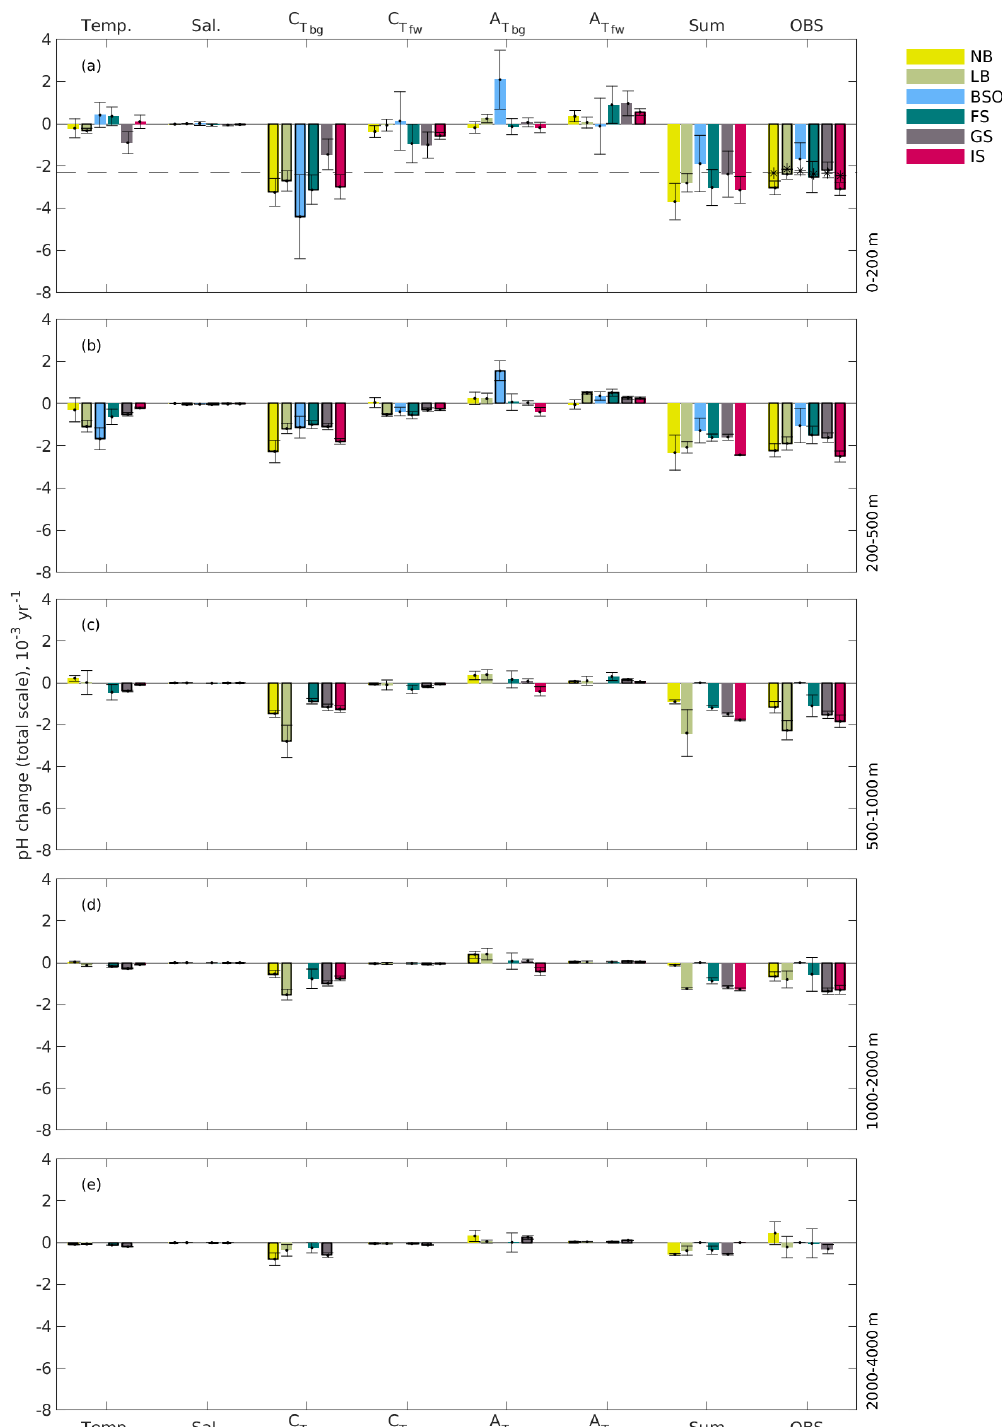
Figure 13. Contribution of observed changes in temperature, salinity, C T , and A T to the observed trend in pH (OBS) over the 1981–2019 period in the Norwegian Basin (NB), Lofoten Basin (LB), Barents Sea Opening (BSO), Fram Strait (FS), Greenland Sea (GS), and Iceland Sea (IS; Fig. 1). The contribution of C T , A T was divided into a freshwater (fw) component and a biogeochemical (bg) component. Bars showing trends that are significantly different from zero are outlined with a black line. The term “sum” indicates the total trend in pH calculated as the sum of the trends associated with these six driving factors. The dashed line and black asterisks indicate the pH trends expected from the change in atmospheric CO 2 during the same period for the whole area and for the separate basins,